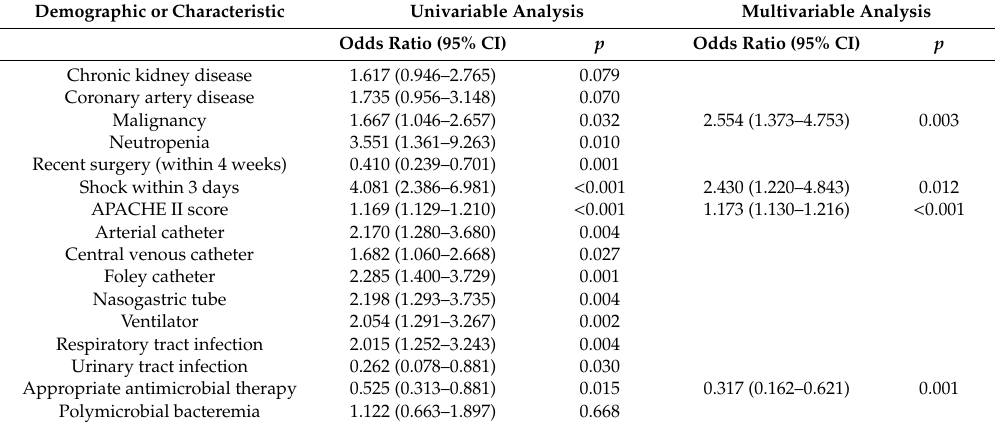
Table 2. Logistic regression analysis of predictors for 14-day mortality among patients with Acinetobacter baumannii